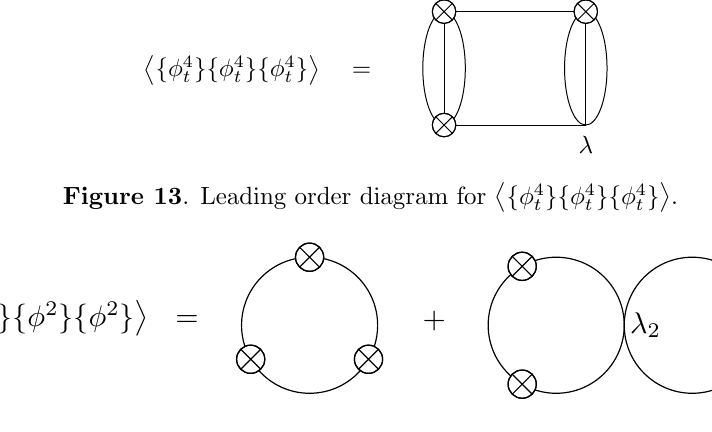
Figure 14 . Leading order diagrams